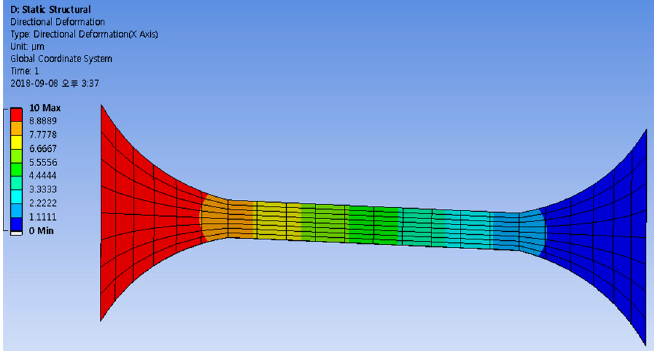
Figure 7. The ratio for reduced section and interesting range at the specimen.